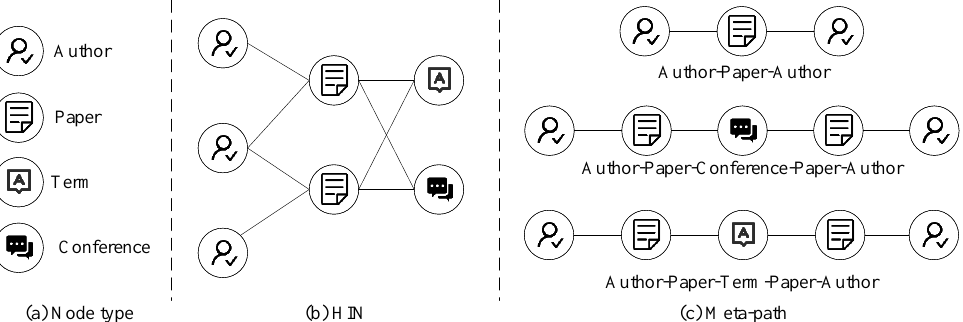
Figure 1. HIN example of paper dataset DBLP. ( a ) Four types of nodes (i.e., Author, Paper,